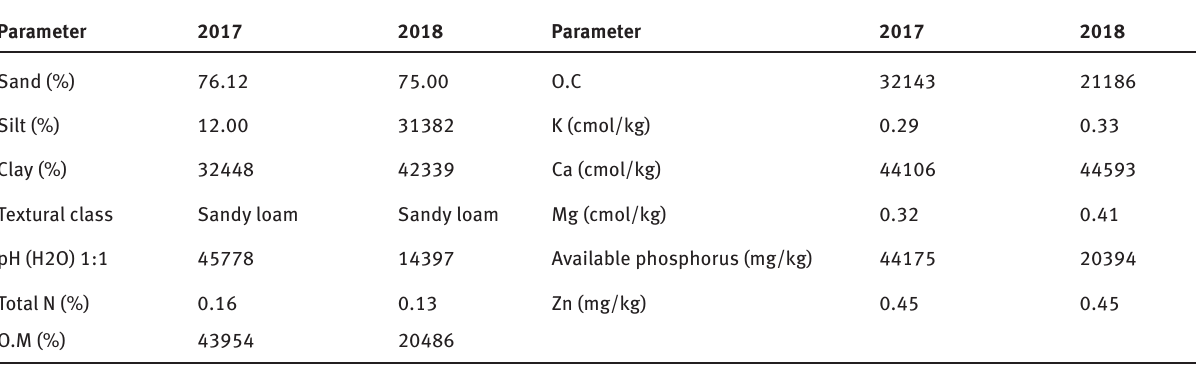
Table 1: Soil physical and chemical property prior planting (0-15cm)